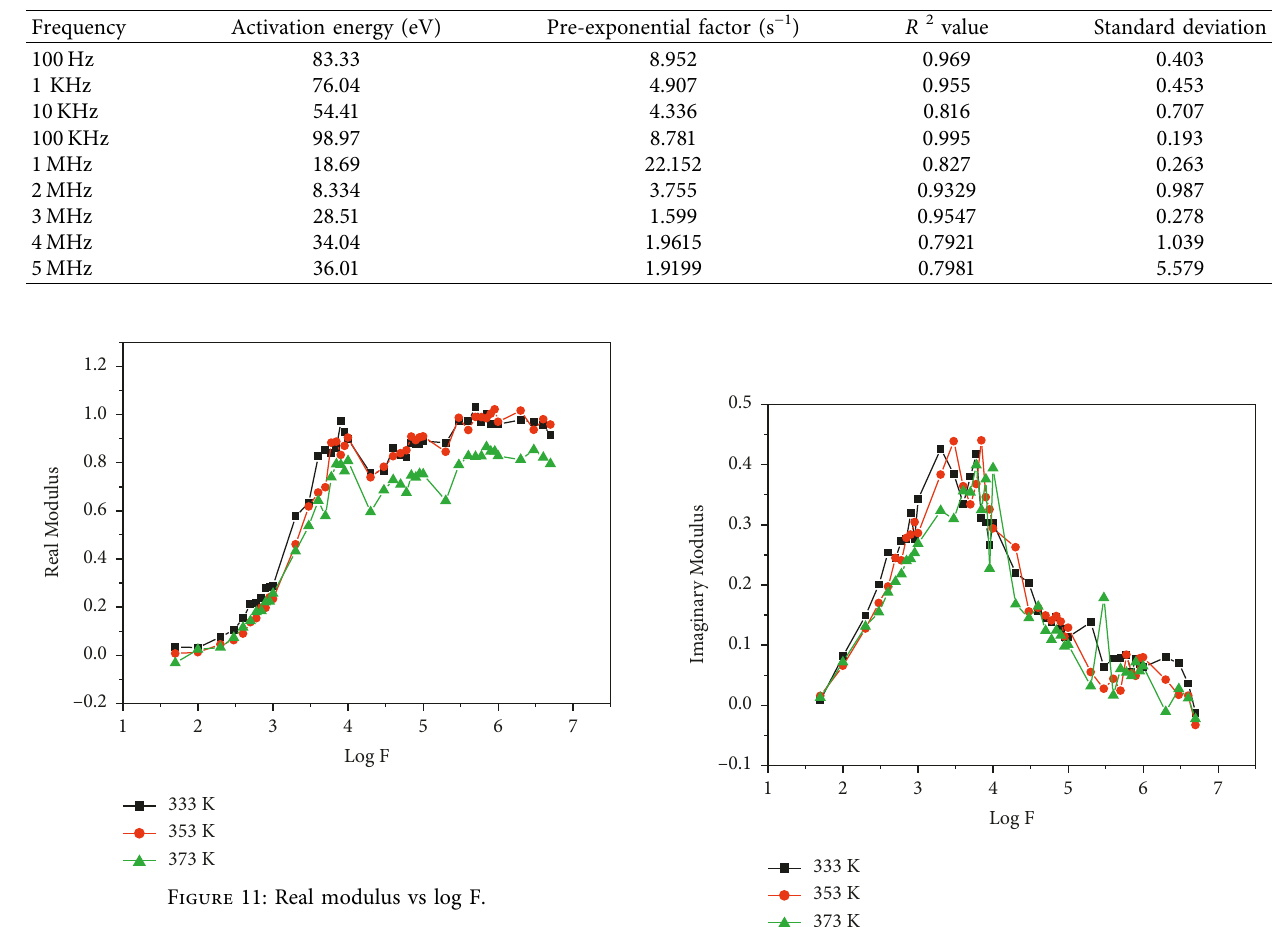
Table 1: Activation energy ( E a ) obtained from impedance values.